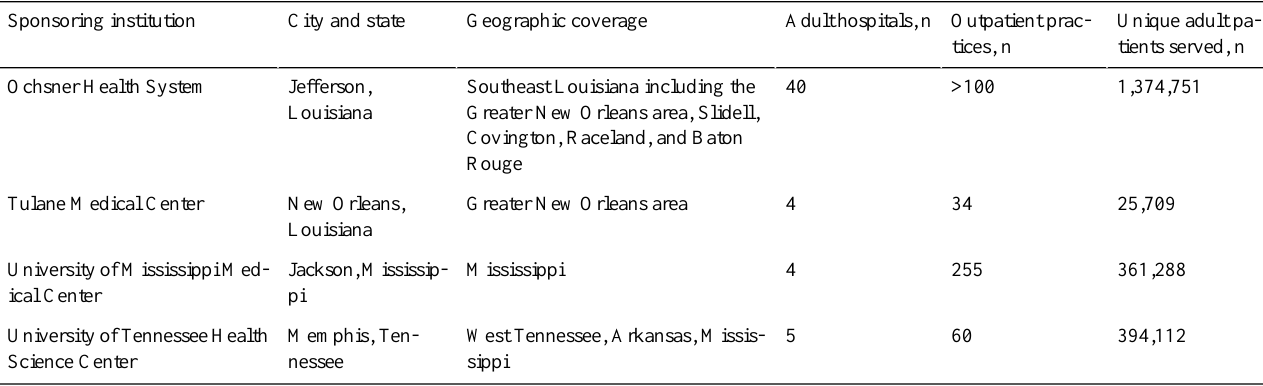
Table 1. Southern Obesity and Diabetes Coalition practice-based research network locations and characteristics.